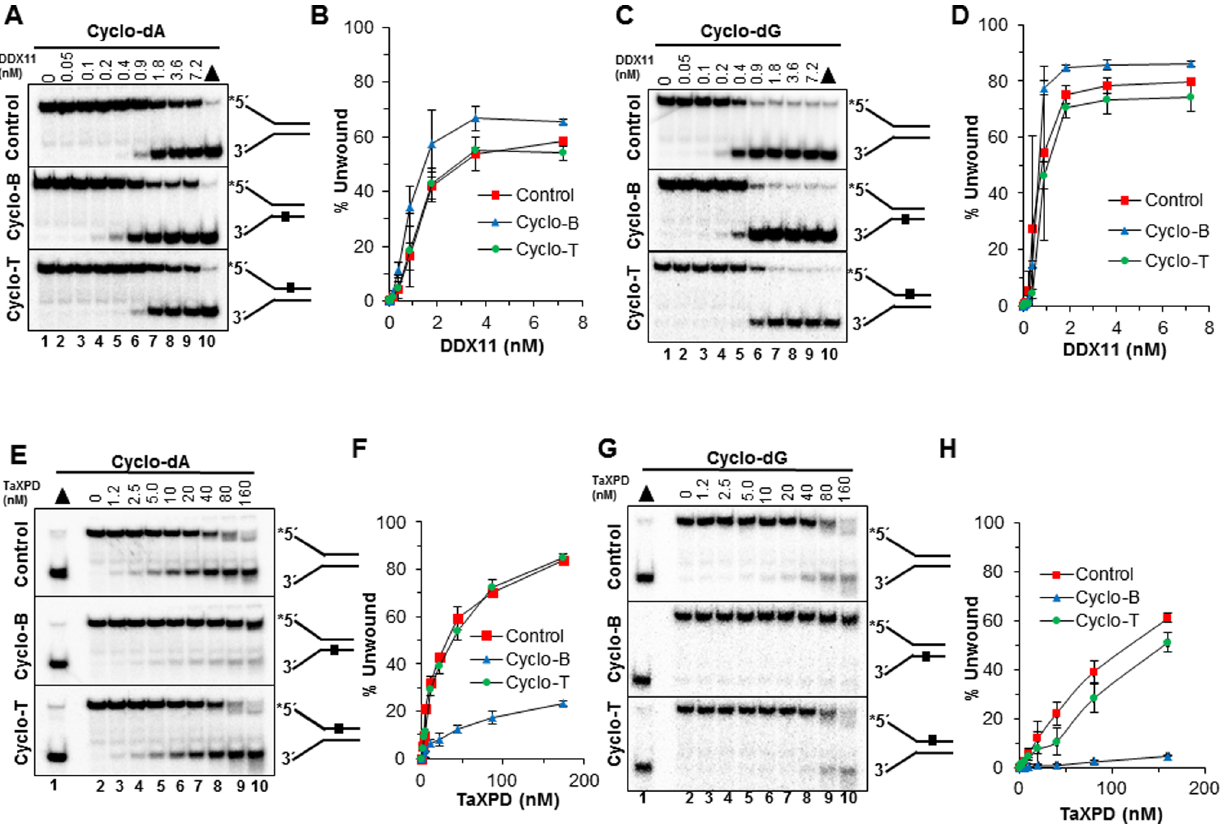
Figure 5. Effect of a site- and strand-specific cyclopurine lesion on DDX11 or taXPD helicase activity. Helicase reactions of 20 m l were carried out by incubating the appropriate DDX11 or taXPD concentrations with 0.5 nM forked duplex DNA that contained a cyclopurine lesion in the top strand (translocating-Cyclo T), bottom strand (nontranslocating-Cyclo B), or neither strand (Control) at 37 u C, for 15 min under standard helicase assay conditions described in the Materials and Methods. A, DDX11 unwinding of undamaged and cyclo dA damaged DNA substrates. Lane 1, no enzyme control; lanes 2–9, indicated concentrations of DDX11; lane 10, heat-denatured DNA substrate control. B, Quantification of DDX11 helicase activity on cdA substrates with error bars. C, DDX11 unwinding of undamaged and cyclo dG damaged DNA substrates. Lane 1, no enzyme control; lanes 2–9, indicated concentrations of DnaB; lane 10, heat-denatured DNA substrate control. D, Quantification of DDX11 helicase activity on cdG substrates with error bars. E, taXPD unwinding of undamaged and cyclo dA damaged DNA substrates. Lane 1, heat-denatured DNA substrate control; lane 2, no enzyme control; lanes 3–10, indicated concentrations of taXPD. F, Quantification of taXPD helicase activity on cdA substrates with error bars. G, taXPD unwinding of undamaged and cyclo dG damaged DNA substrates. Lane 1, heat-denatured DNA substrate control; lane 2, no enzyme control, lanes 3–10, indicated concentrations of taXPD. H, Quantification of taXPD helicase activity on cdG substrates with error bars. DNA and become available to bind and unwind the tracker substrate.